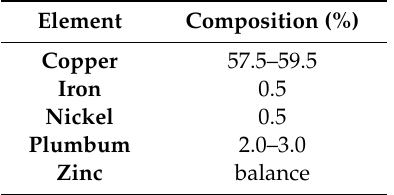
Table 2. The element composition of Cu alloy.